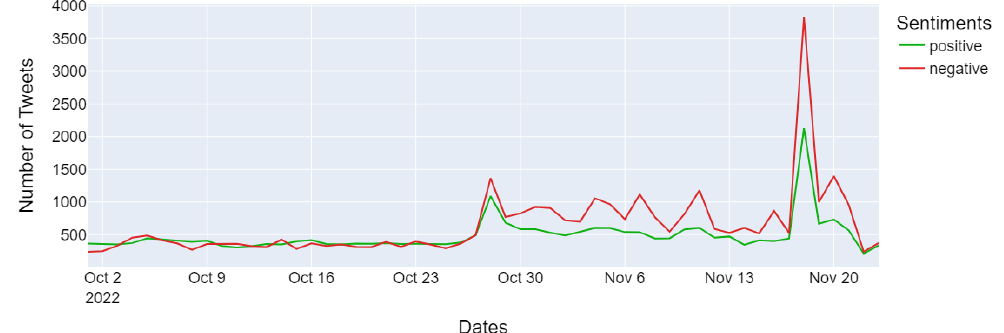
Figure 3. Timeline of relevant Tweets and their respective sentiment